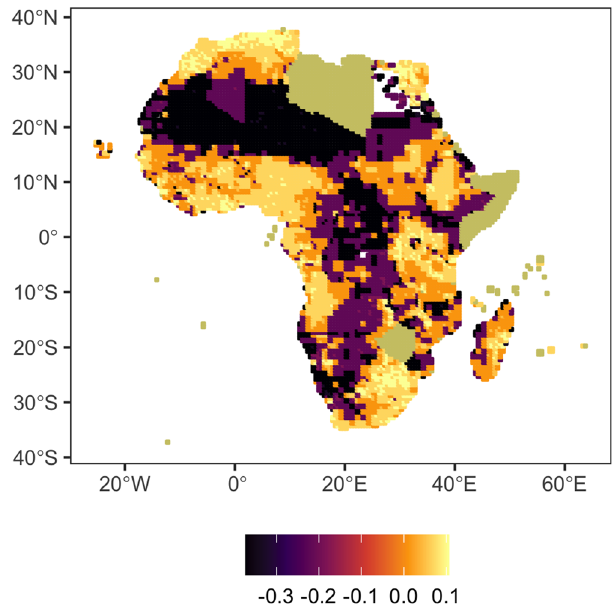
Fig. 4 | Estimates of the effect of drought events on migration, by grid-cell. Missing information corresponds to countries for which data on GDP are not